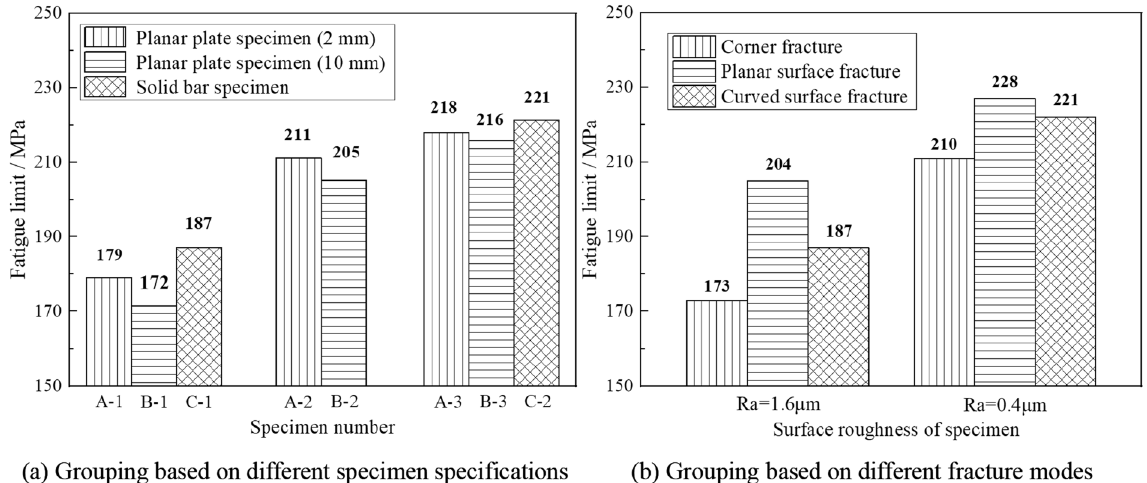
Figure 3. Fatigue limits of 8 groups specimens of based on different grouping